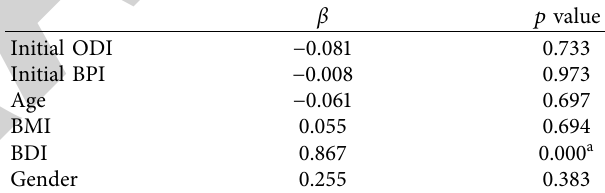
Table 4: Association between residual pain and various